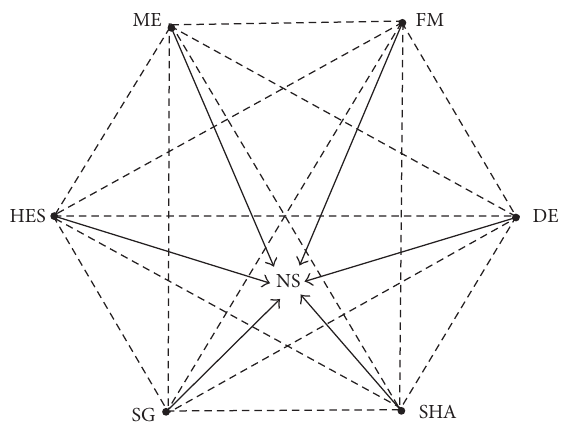
Figure 2: Network of clinical trials according to the comparison of specific classes of initial injected solutions. NS, normal saline; FM, fibrinogen mixture; DE, dextrose; SHA, sodium hyaluronic acid; SG, succinylated gelatin; HES, hydroxyethyl starch; and ME, mesna. (OR = 0.18, 95% CI (0.04, 0.89)). The OR value for dextrose ranged from 1.26 to 2.39 compared with the others, while the difference failed to reach any statistical significance. The OR value for hyaluronate acid ranged from 0.85 to 1.62 compared with the others, and there was no significant